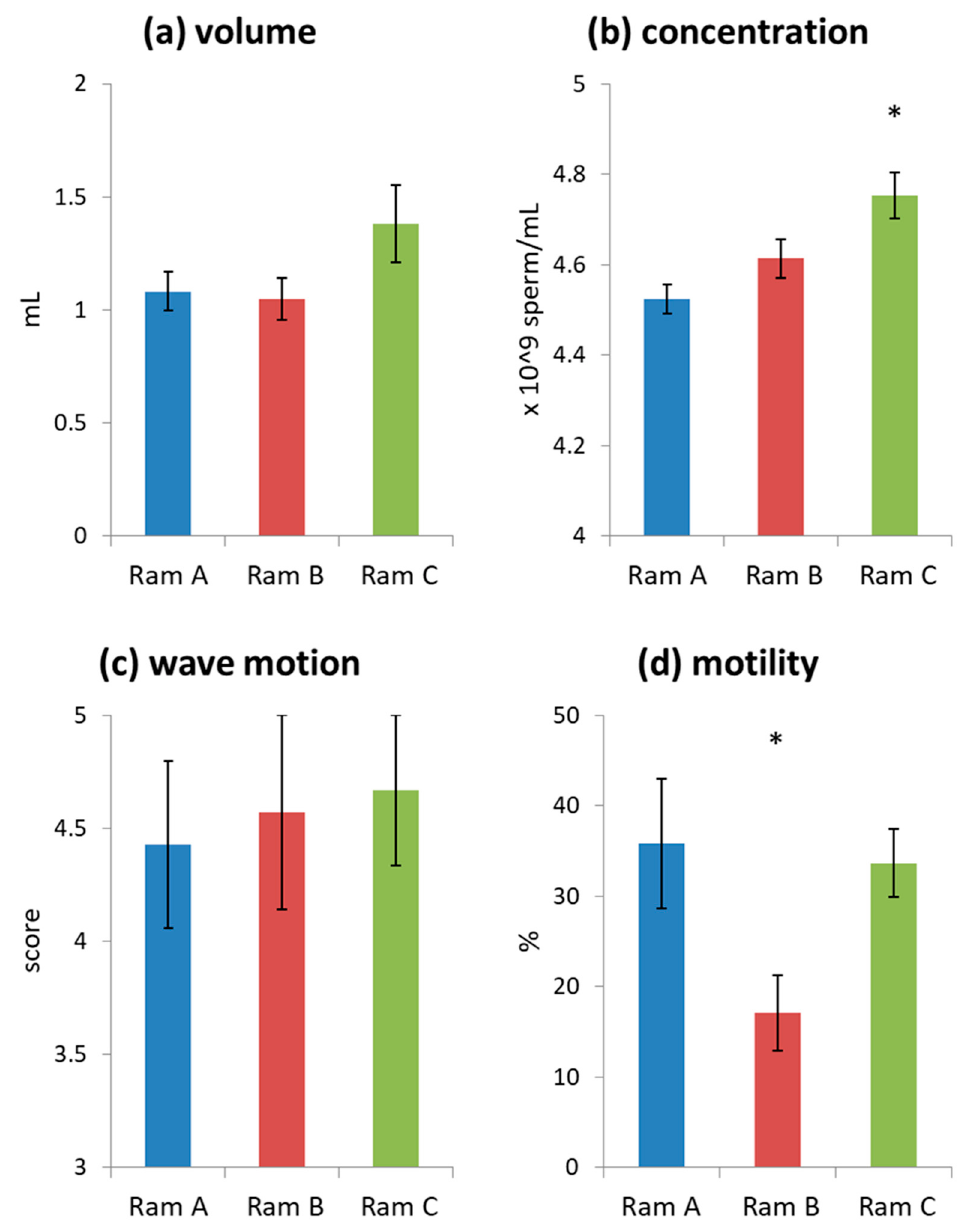
Figure 1. Average ejaculate characteristics grouped by Ram (mean ± s.e.): ( a ) undiluted ejaculate volume; ( b ) undiluted sperm concentration; ( c ) initial wave motion; ( d ) sperm motility of samples diluted with phosphate buffered saline (PBS) + bovine serum albumin (BSA) to a standard concentration of 20 × 10 6 spermatozoa mL − 1 . Significant differences are marked with an *.